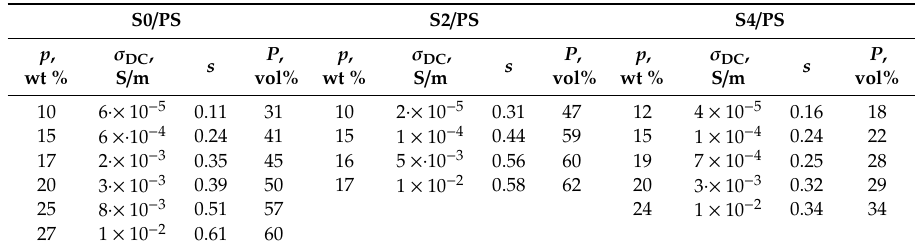
Table 1. Parameters describing charge-transport properties of CNH / PS composites below the percolation